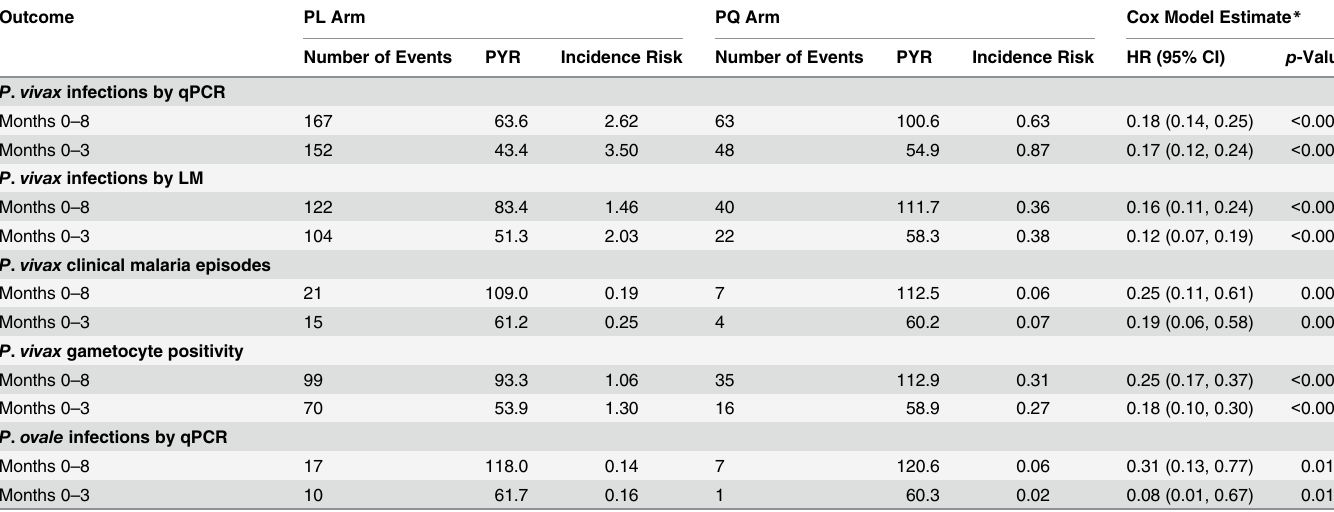
Table 2. Incidence of first (or only) P . vivax / P . ovale re-infections, P . vivax clinical malaria episodes, and P . vivax gametocyte positivity in treatment groups during the entire 8-mo follow-up period and during the first 3 mo of follow-up.